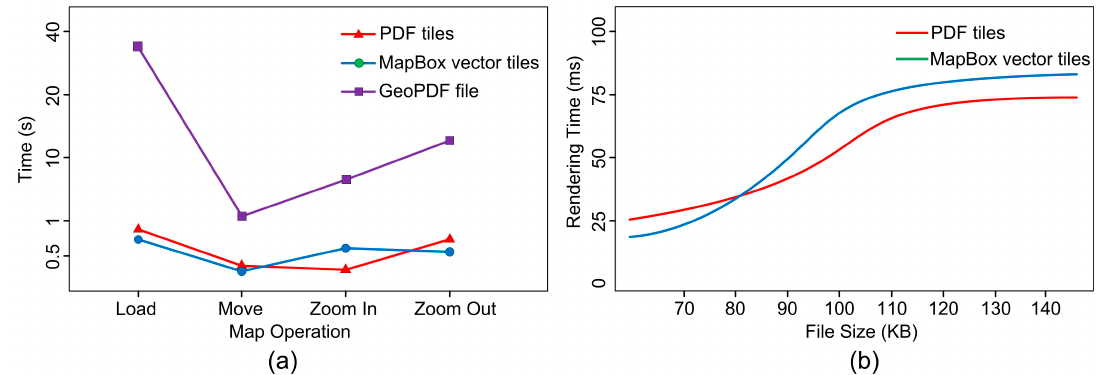
Figure 22. The rendering performance of three types of map data: ( a ) the time-consumption of the initial map loading, map move, map zoom in, and map zoom out; ( b ) the rendering time comparison for the MapBox vector tiles and PDF tiles as a function of file size.